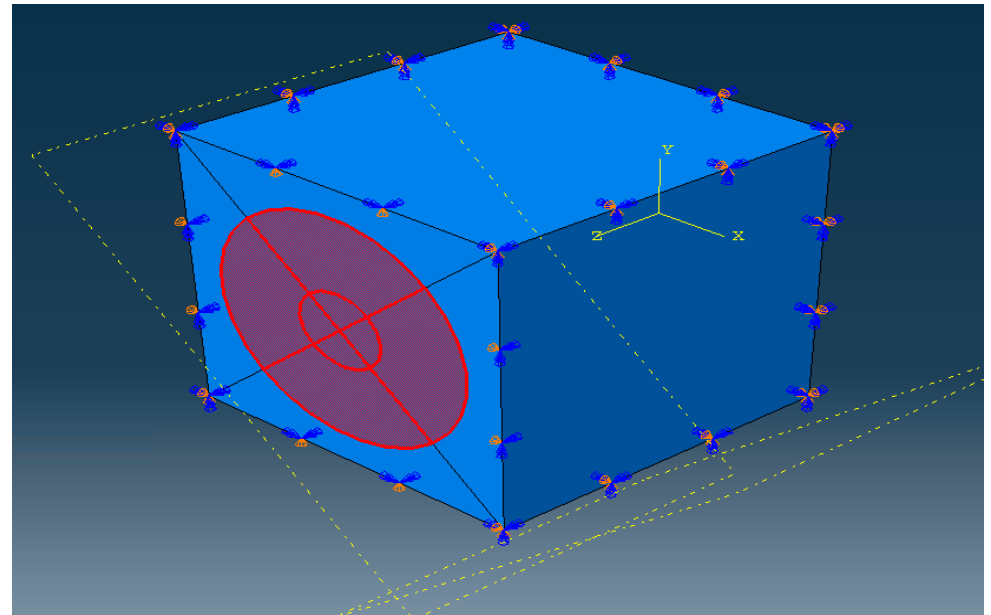
Figure 2. 3-D unit cell model where the purple circle indicates the fiber and the square represents the matrix within which the fiber is enclosed. The boundary conditions are also shown here.